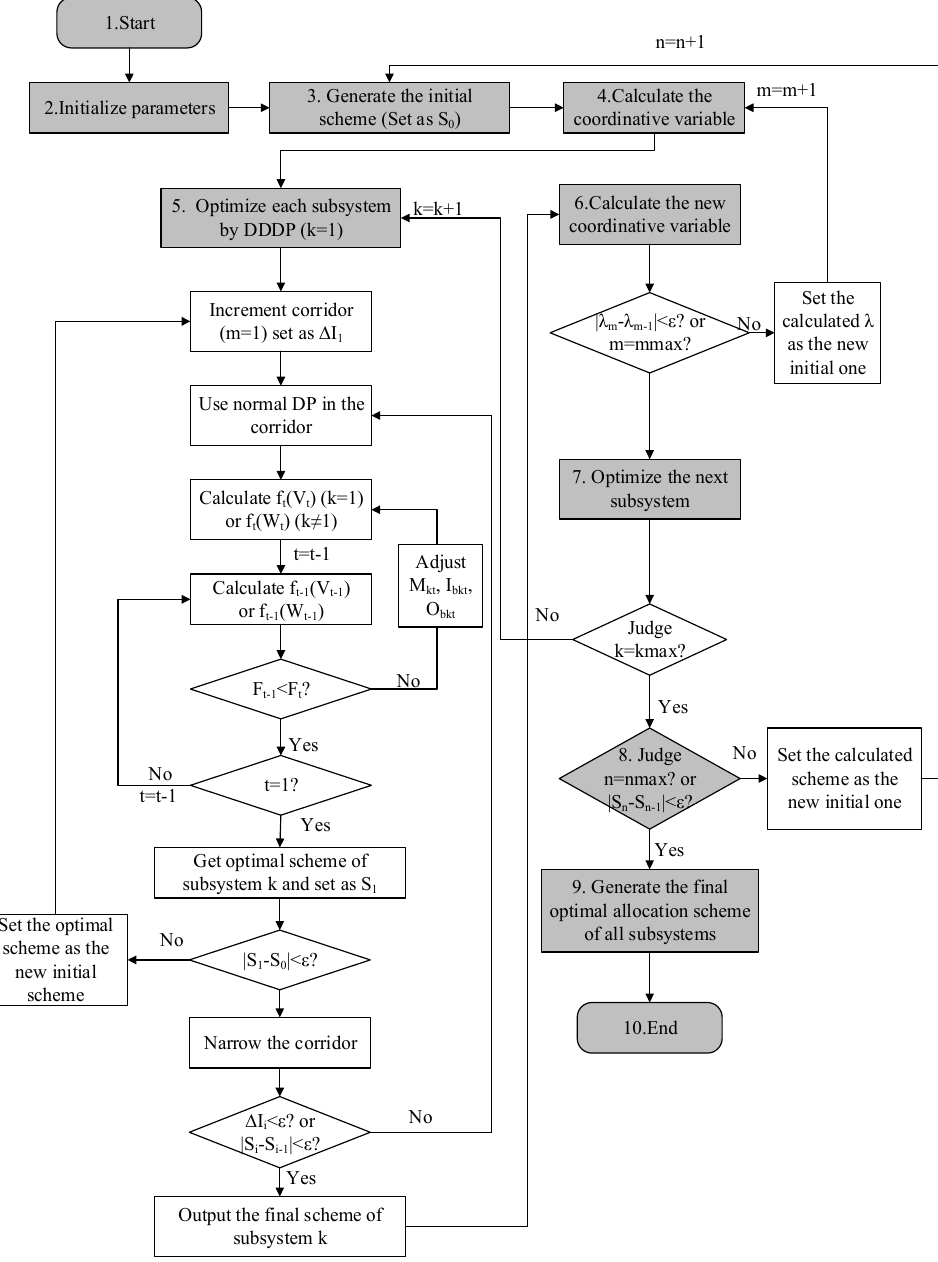
Figure 3. The procedure of large system for water resources.